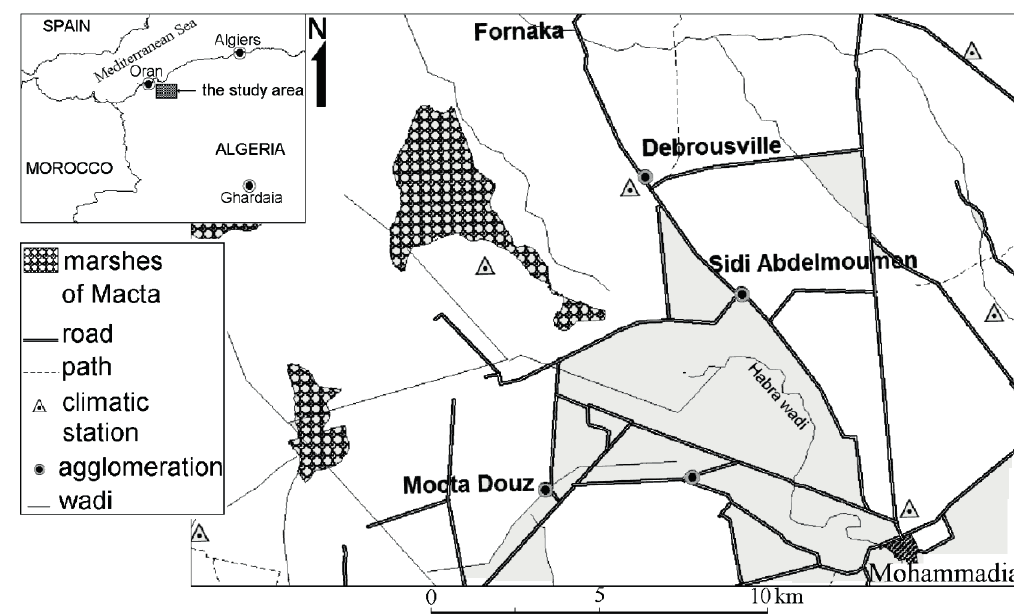
Fig. 1 Map of the study area located in the Habra plain